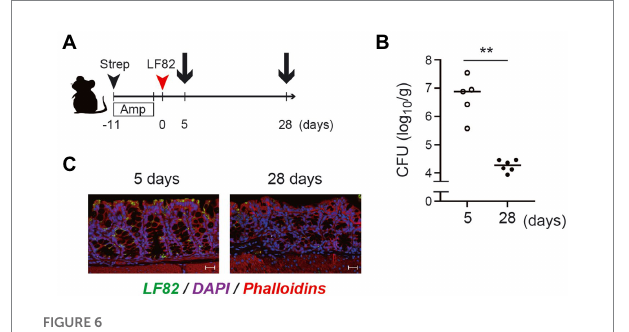
FIGURE 6 The number of LF82 bacteria which invade the mucosal epithelium decreases at the late stage of the infection. (A) The timing for the preparation of gut derived from LF82-infected mice is shown. (B) The invasion of LF82 into the mucosal epithelium at the early (5 days) and the late (28 days) stages was assessed by the number of bacteria in the gut. (C) Two representative immunofluorescence images are shown; left panel is the mucosal epithelium at 5 days and right panel is at 28 days. Data shown are mean ± SD ( N = 5). **, p < 0.01 by Mann–Whitney U